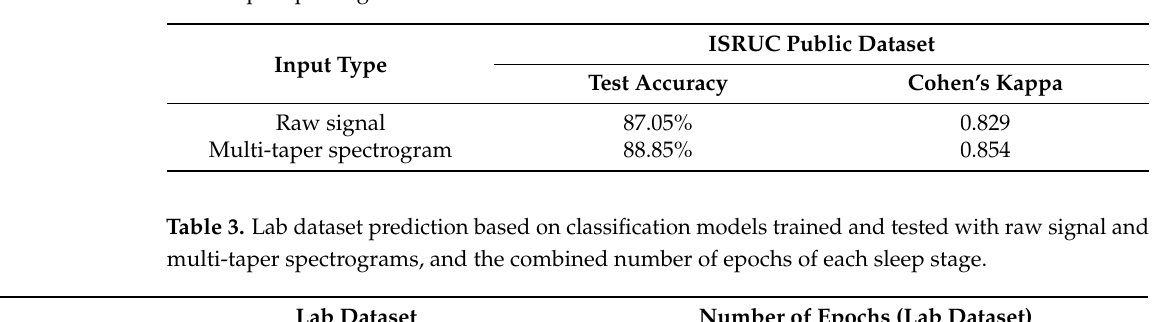
Table 2. Public dataset based on classification models trained and tested with raw signals and multi-taper spectrograms.